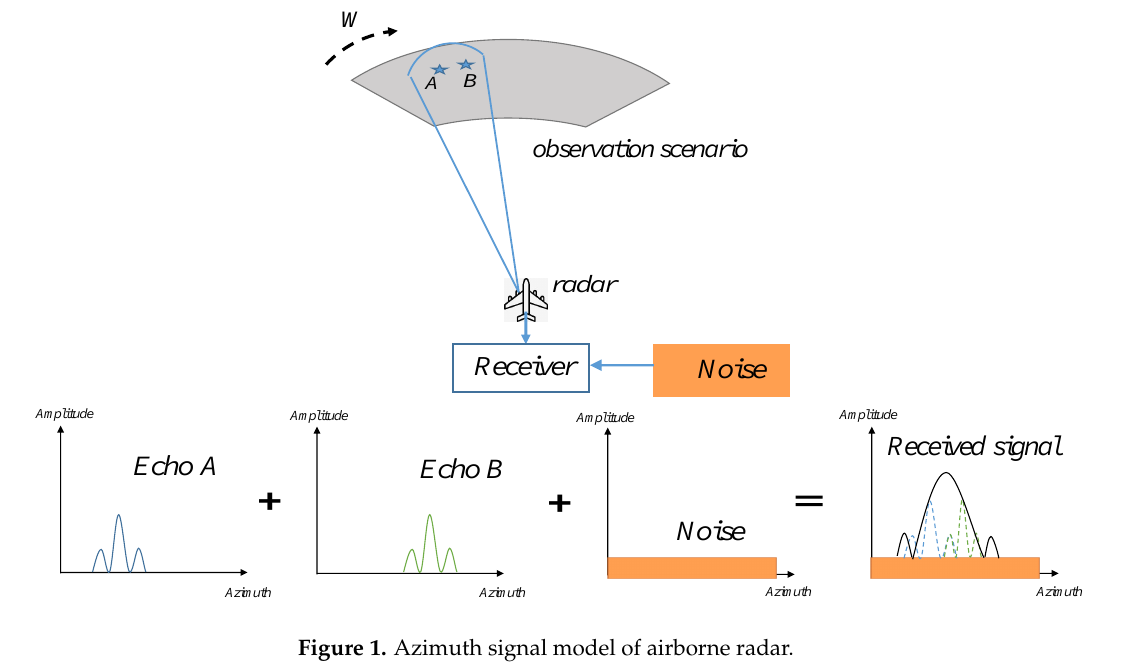
Figure 1. Azimuth signal model of airborne